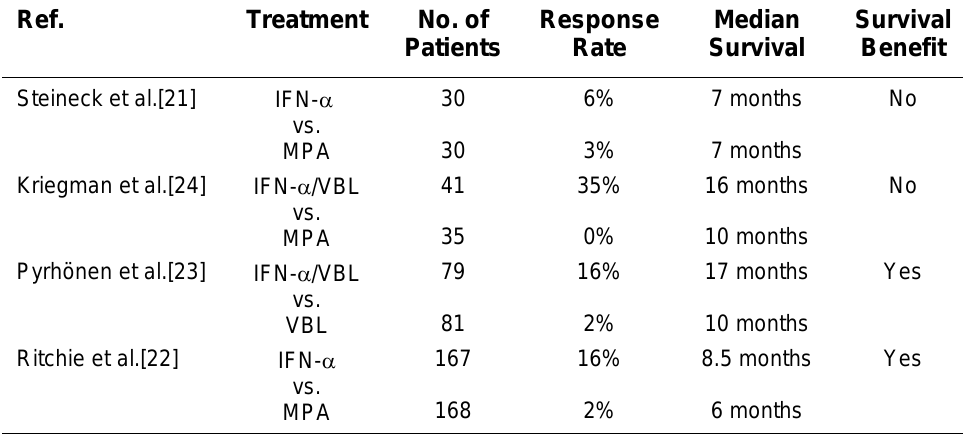
Randomized Trials Evaluating the Effect of IFN- α on Advanced RCC Patients’ Survival Ref. Treatment No. of